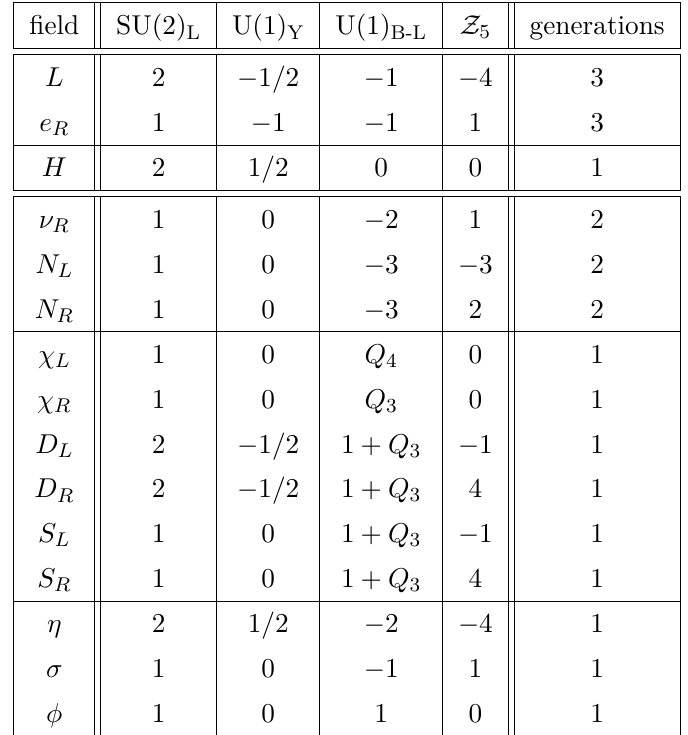
Table 1 . Charges and representations for all particles participating in the neutrino or dark matter mass generation. The integers n in the fifth column are an abbreviation for ω n , where ω = e 2 iπ